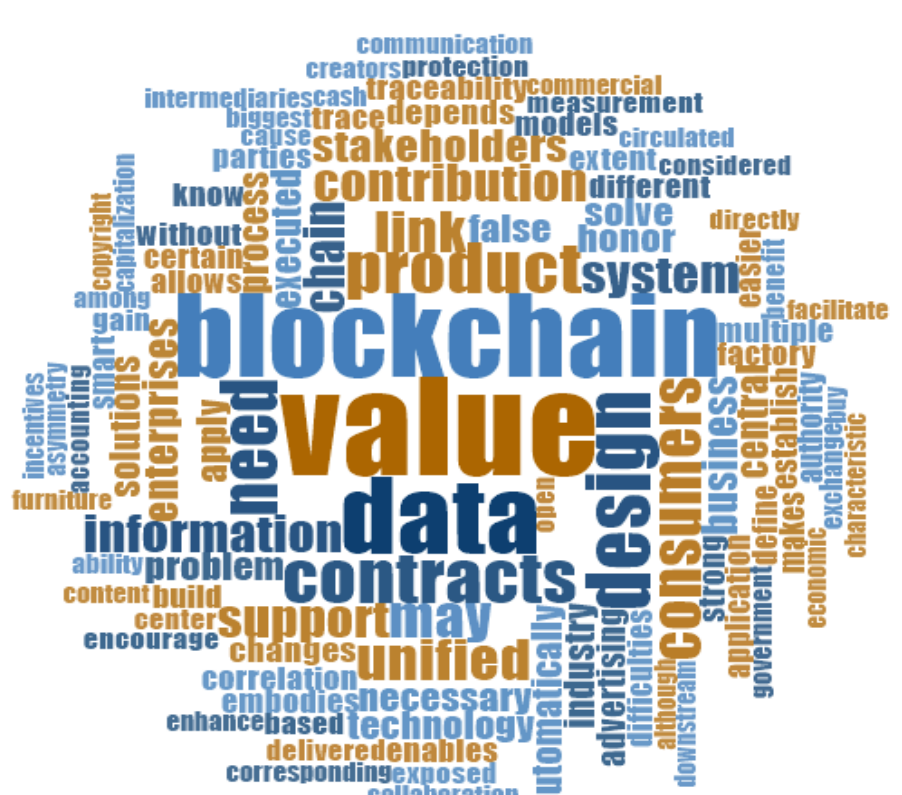
Figure 13. Interview word frequency (exported from NVivo 11 software).